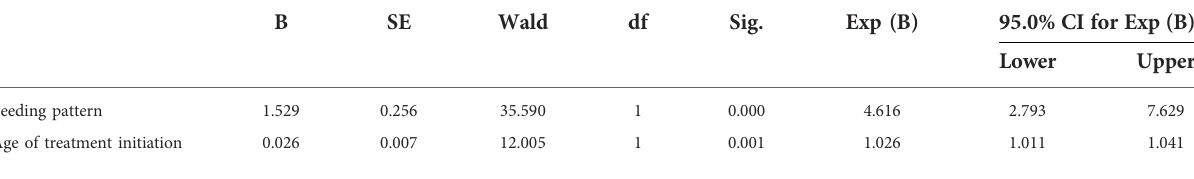
TABLE 3 Factors related to the treatment outcome.